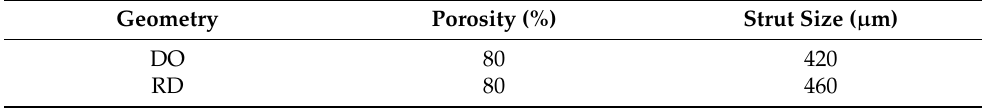
Table 2. CAD values of porosity and strut size for DO and RD geometries.